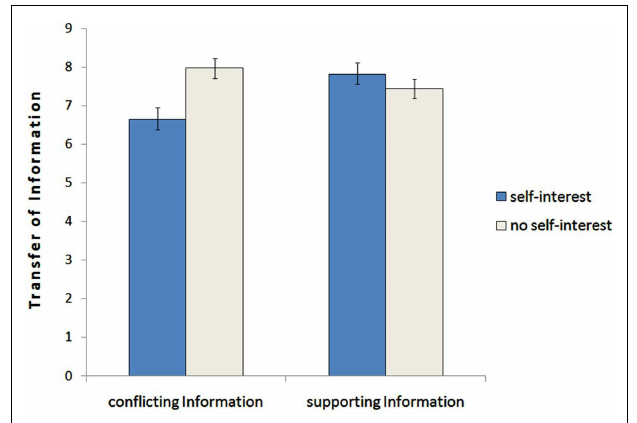
FIGURE 1 | Mean differences representing the transfer of information regarding supportive and conflicting information for advisors with self-interest and without self-interest. The error bars represent SEM